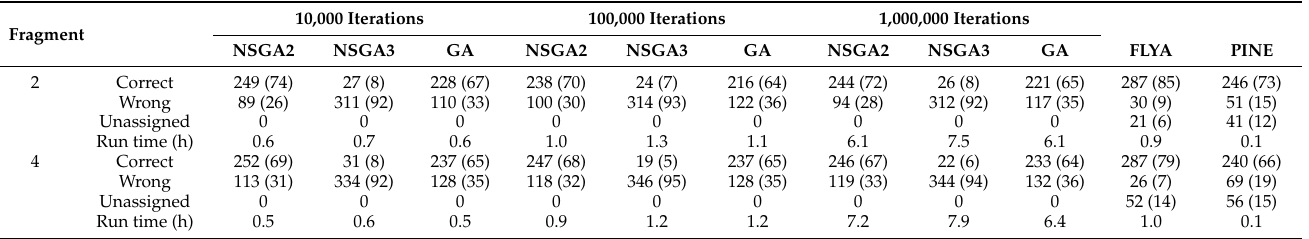
Table 4. Chemical shift assignment results for the 2nd and 4th fragments of Fes SH2 for different iteration parameter values.